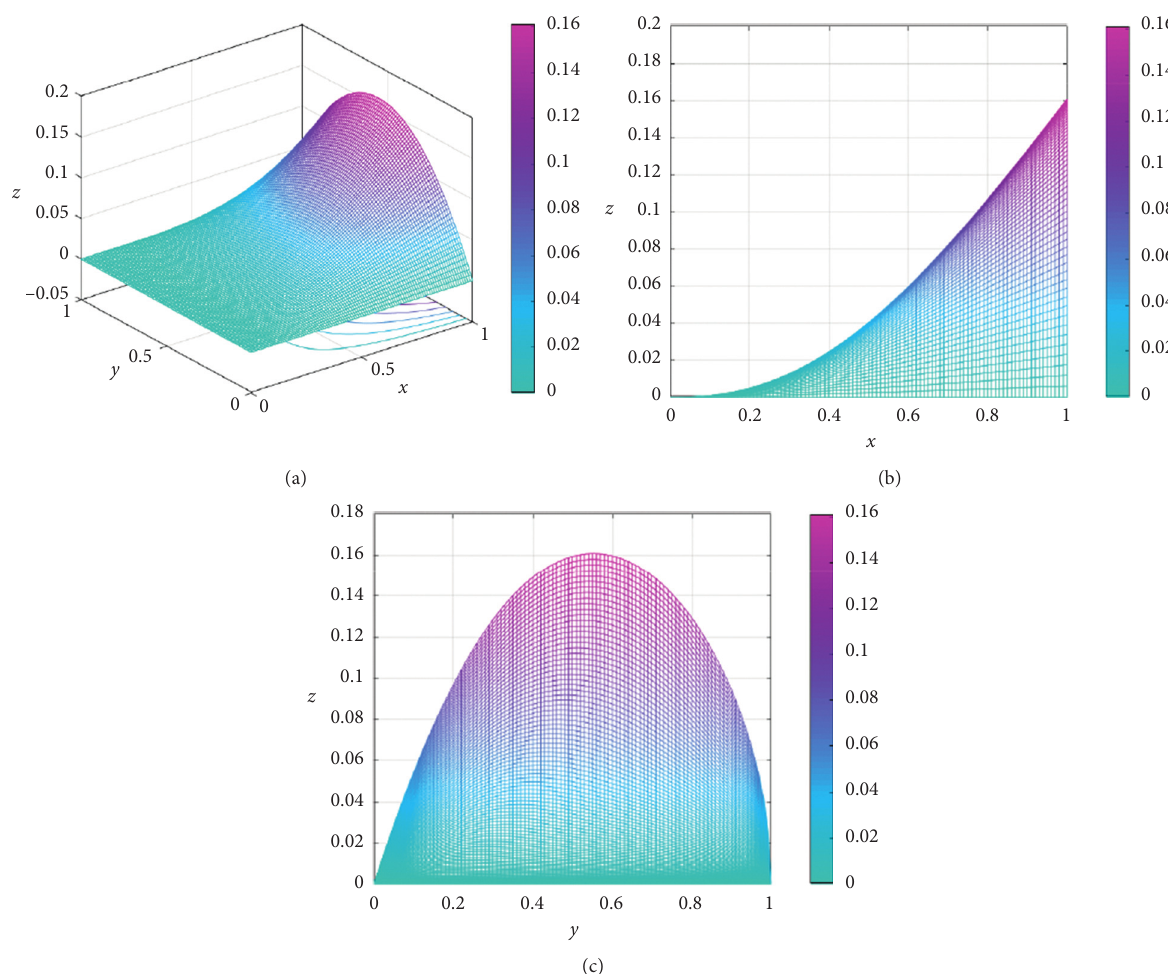
Figure 1: G ( x,y ) for α � 7/2. (a) G α ( x , y ) and contours. (b) Projection on xz . (c) Projection on yz α